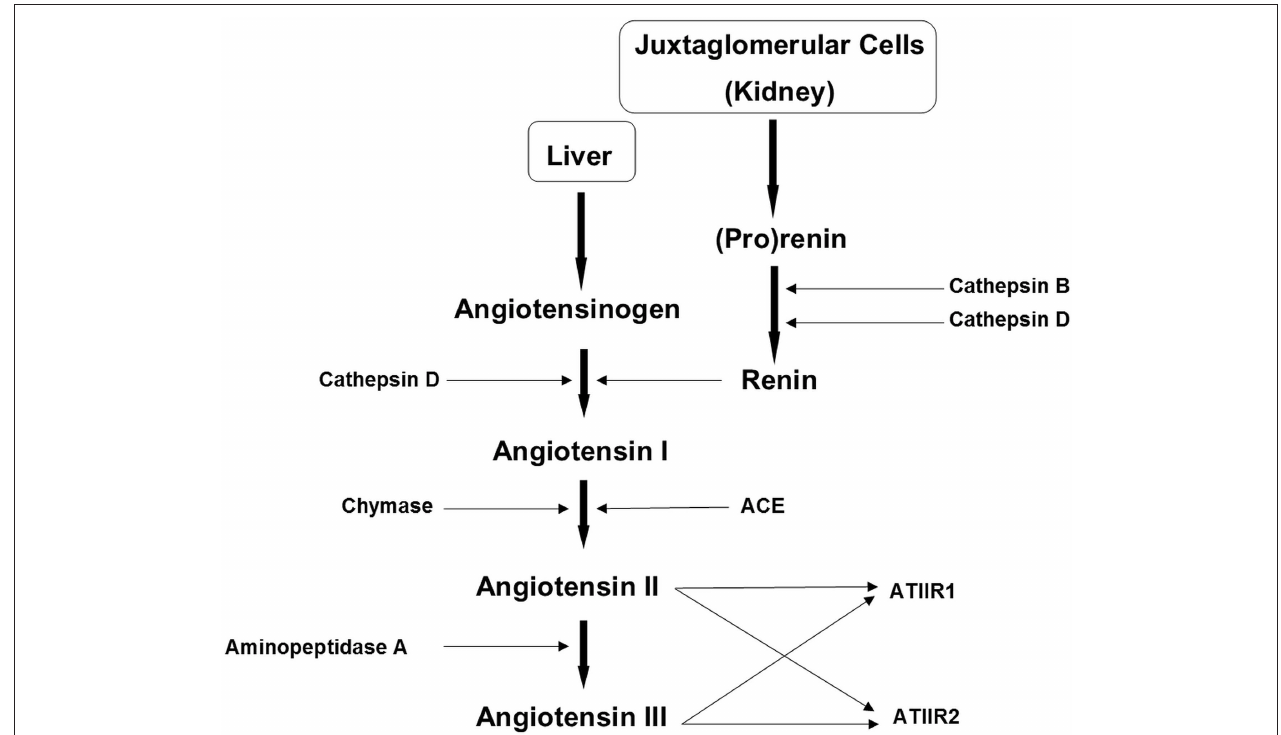
FIGURE 4 | The renin-angiotensin system (RAS). In the RAS (pro)renin activation is caused by its binding to the (pro)renin receptor. Cathepsins B and D are also renin-activating enzymes. Renin and cathepsin D convert angiotensinogen to angiotensin I (ATI) which is acted upon by angiotensin converting enzyme (ACE) and chymase, to produce angiotensin II (ATII). Aminopeptidase A converts ATII to angiotensin III (ATIII). ATII and ATIII act on angiotensin II receptor 1 (ATIIR1) and angiotensin II receptor 2 (ATIIR2). Redundancy in the pathway has been revealed in the form of cathepsins B and D, aminopeptidase A and chymase. Reproduced with permission from Integrative Cancer Science and Therapeutic (